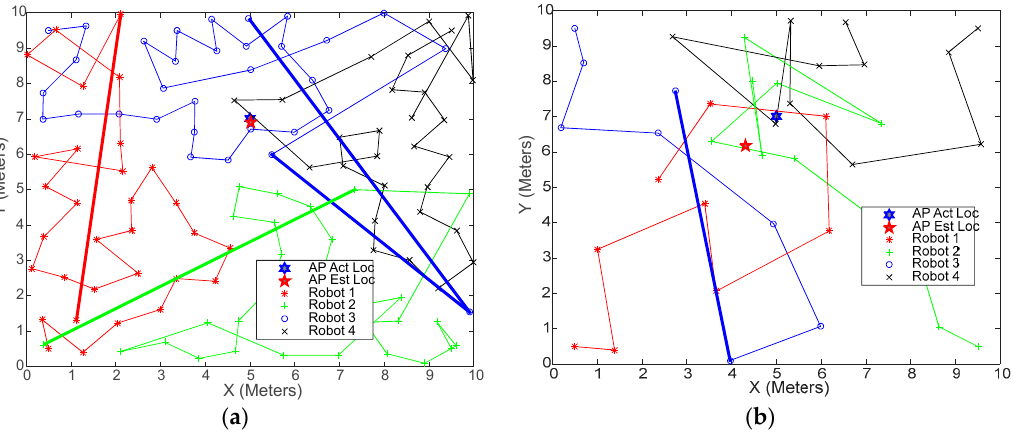
Figure 13. Robot navigation path showing the problem of the high overhead caused by the random search algorithm: ( a ) for distributed WiMAP algorithm; ( b ) for distributed DWiMAP.